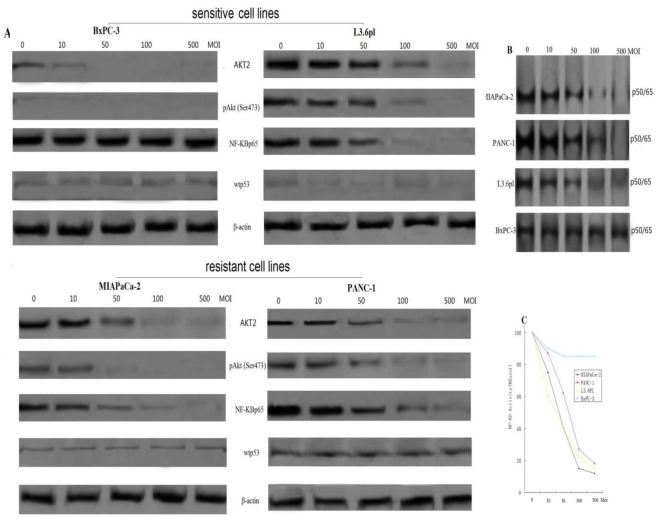
Effects of AKT2 inhibition on NF-κB activity. (A) L3.6pl, BxPC-3, PANC-1 and MIAPaCa-2 cells were treated with 10, 50, 100 or 500 MOI rAAV2-AKT2 siRNA for 48 h. AKT2, pAKT (pAKTscr473), wt-p53 and NF-κBp65 levels were detected by western blotting; (B) Nuclear extracts prepared from L3.6pl, BxPC-3, PANC-1 and MIAPaCa-2 cells after 48 h incubation with 10, 50, 100 and 500 MOI rAAV2-AKT2 siRNA, and were assayed by EMSA; (C) NF-κB transcriptional activity was estimated using a reporter assay.